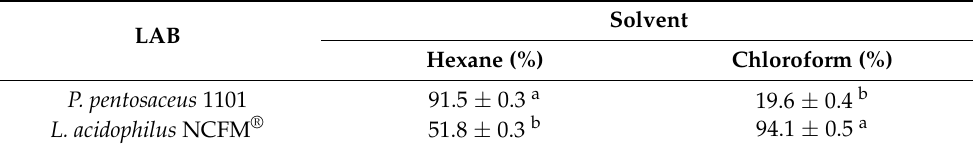
Table 4. Bacterial hydrophobicity (%) of